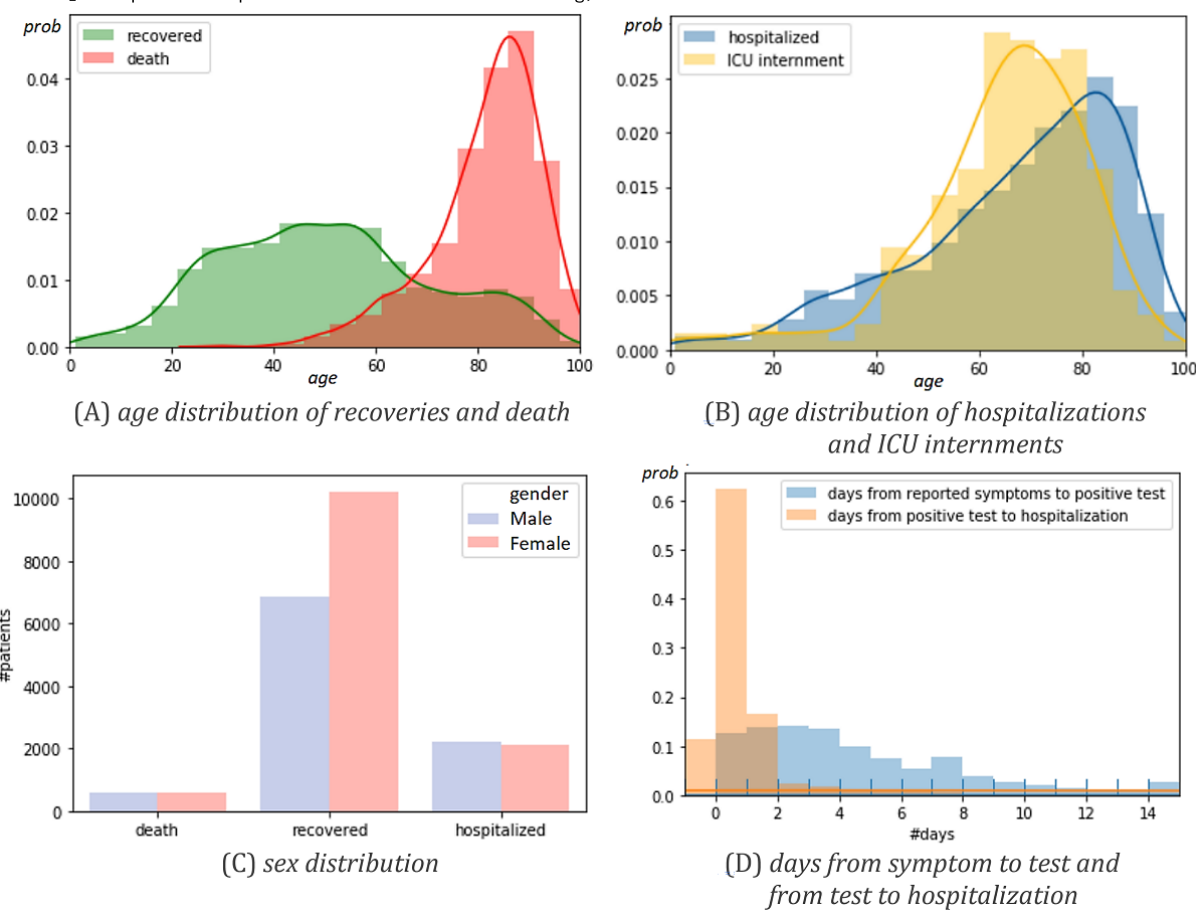
Figure 2. Cohort statistics: (A-C) demographic distribution of infected individuals with known outcome (death and recovery) and stage in the care life cycle (hospitalization and intensive care unit [ICU] admission); (D) average number of days between care stages (the plotted negative bin [ie, negative occurrences] corresponds to hospitalizations before SARS-CoV-2 testing).